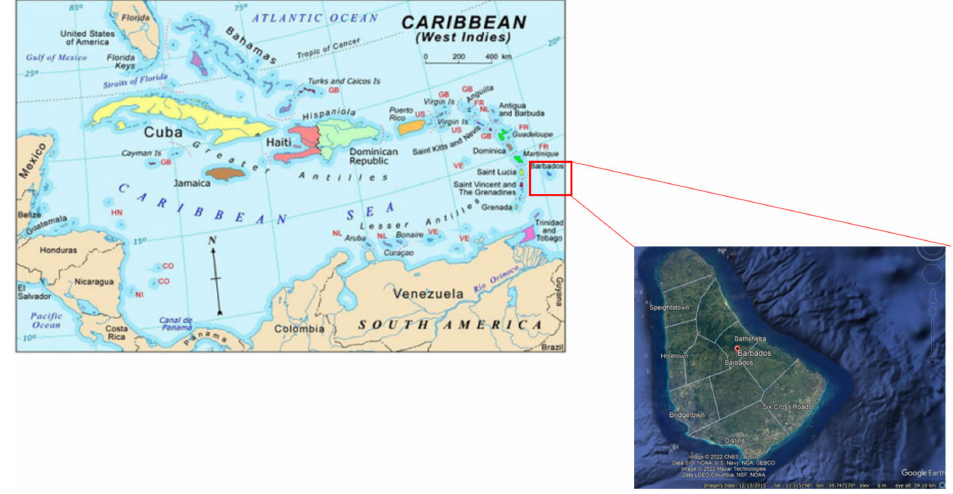
Figure 1. Map of the Caribbean Region showing the location of Barbados [Source: Google